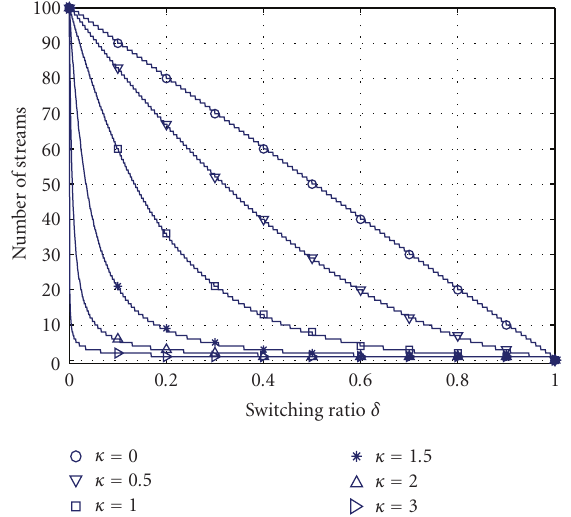
Figure 2: Comparing the switching parameter δ with the number of streams n , which are o ff ered to the broadcast system, depending on the popularity